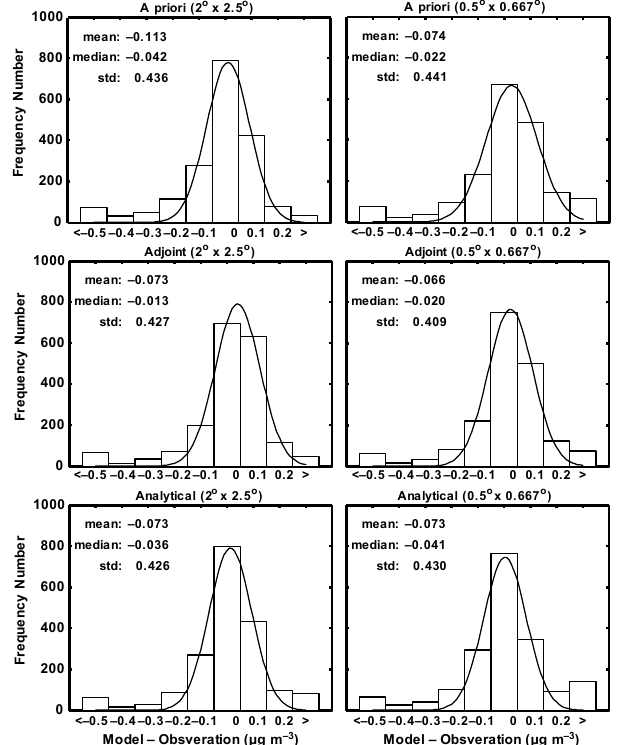
Figure 11. Frequency distribution of the bias of GEOS-Chem simulated 24h average surface BC concentrations for July– September 2006. Results are for 2 ◦ × 2.5 ◦ and 0.5 ◦ × 0.667 ◦ with the a priori or a posteriori emissions from the analytical or adjoint inversions. Also shown are the mean, median, standard deviation, and fitted Gaussian distribution.